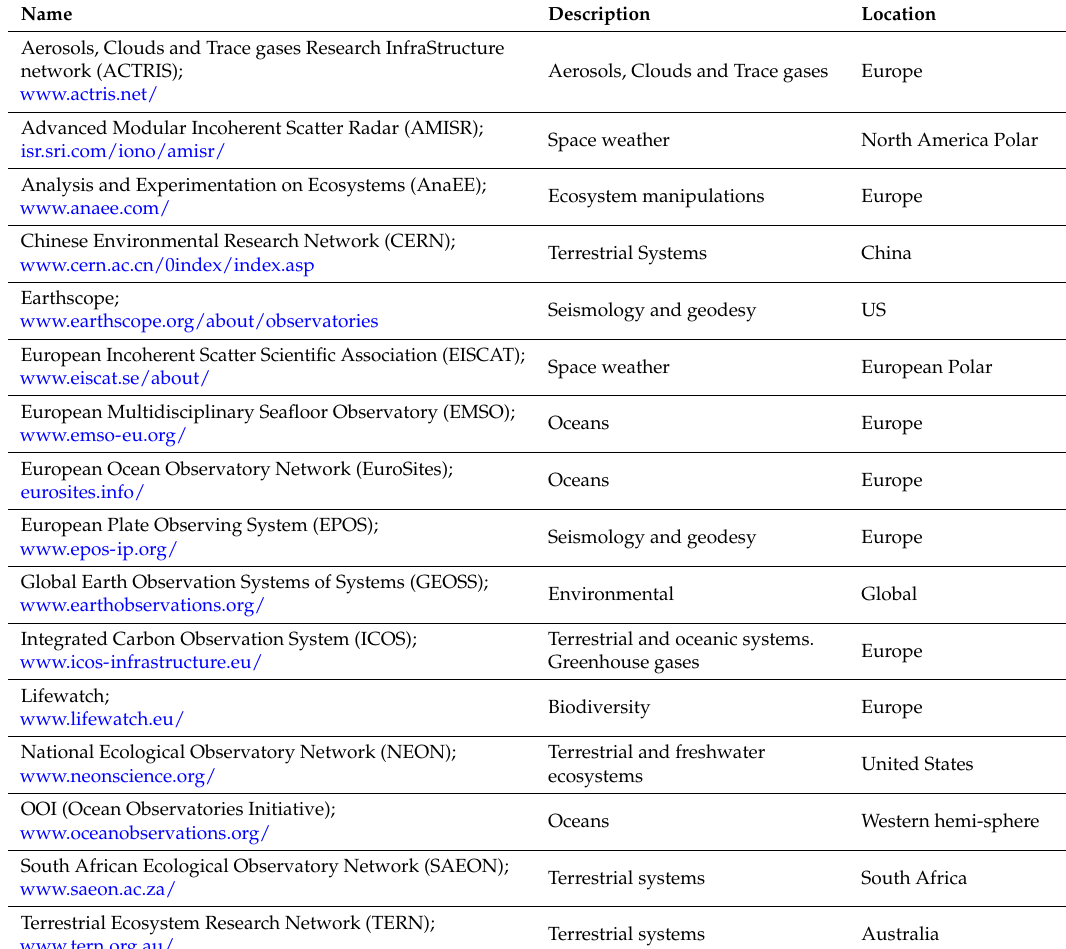
Table 1. Examples of Environmental Research Infrastructures (ERIs) that are designed to address societal challenges across large temporal and spatial scales, e.g., [6]. This demonstrates the global distribution and scientific diversity of